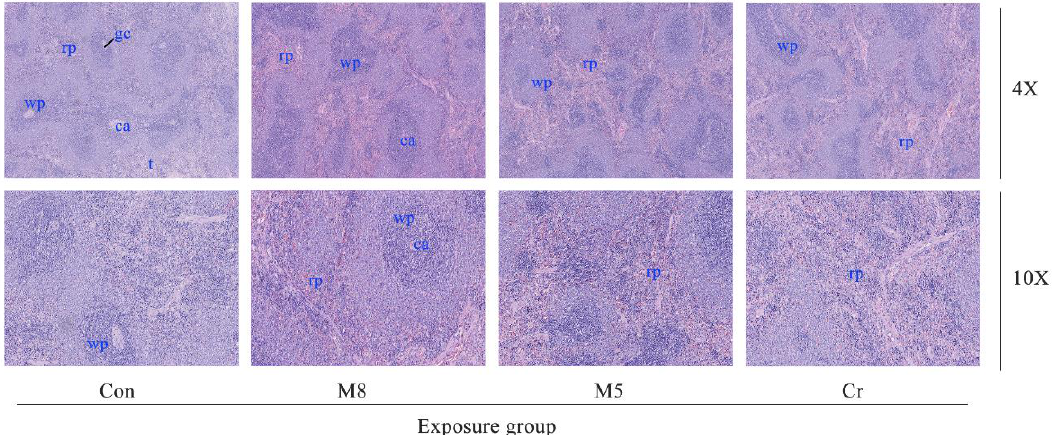
Figure 5. Photomicrographs of spleen histopathology. The images (magnification 4 × , 10 × ) represent the histopathological sections of the spleen. Abbreviations: Con, control group; M8: the mixture of eight common metals (Pb + Cd + Hg + Cu + Zn + Mn + Cr + Ni); M5: the mixture of five non-essential metals (Pb + Hg + Cd + Ni + Cr); Cr, chromium; rp, red pulp; wp, white pulp; t, trabeculae; ca, central artery; gc, germinal center.